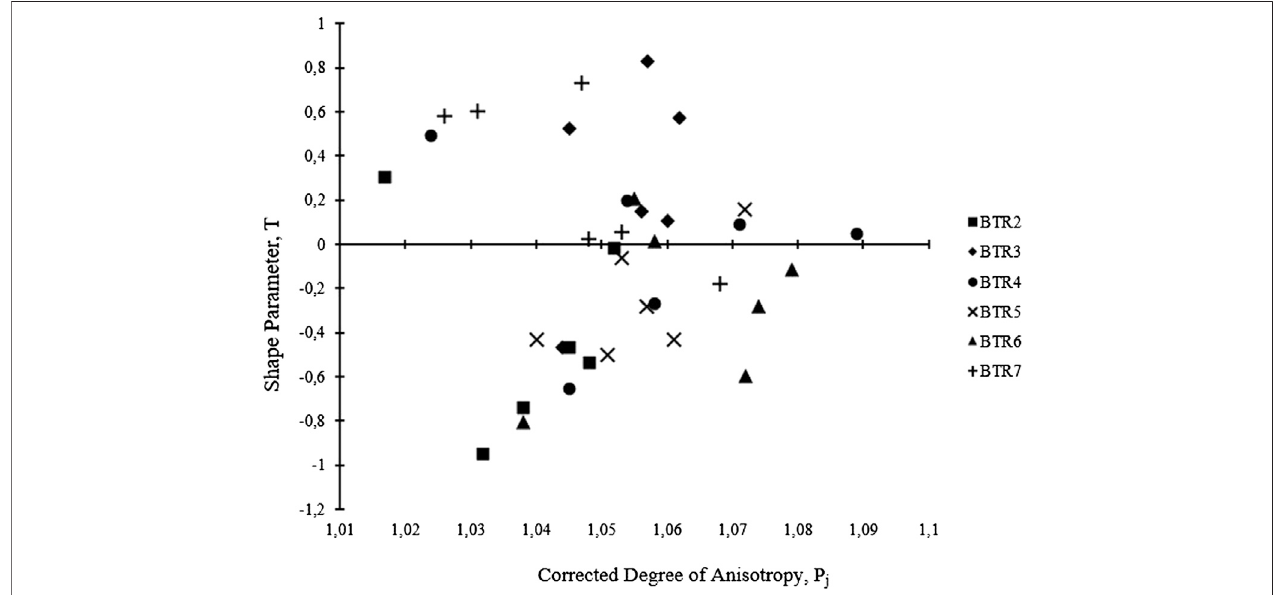
FIGURE 3 | A plot of shape parameter ( T ) and the corrected degree of anisotropy ( P j ). Positive values indicate an oblate shape, whereas negative values indicate a prolate shape.